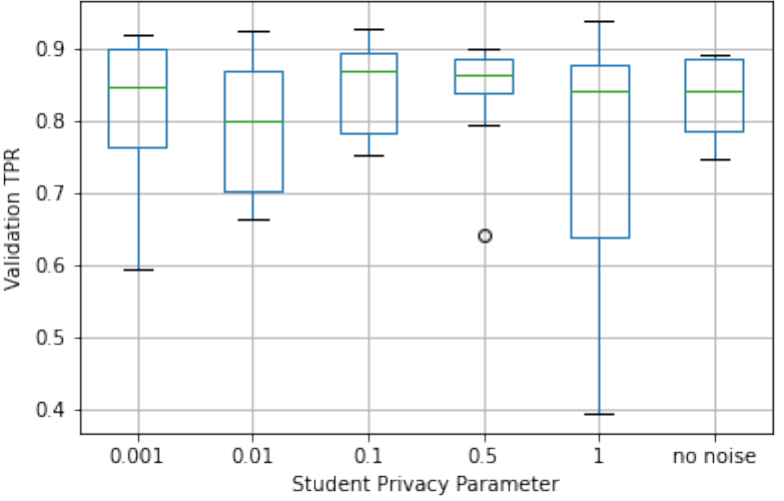
Figure 13. Validation TPR by student privacy parameter ρ in Web Requests dataset.